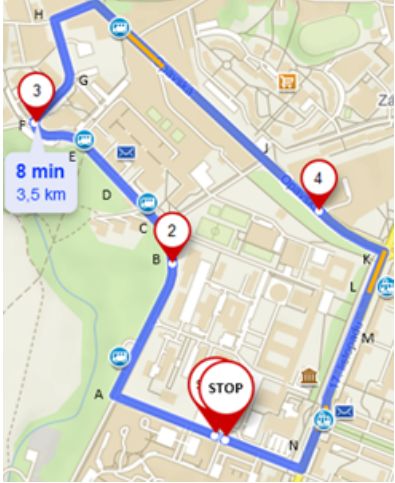
Figure 3. Test route.